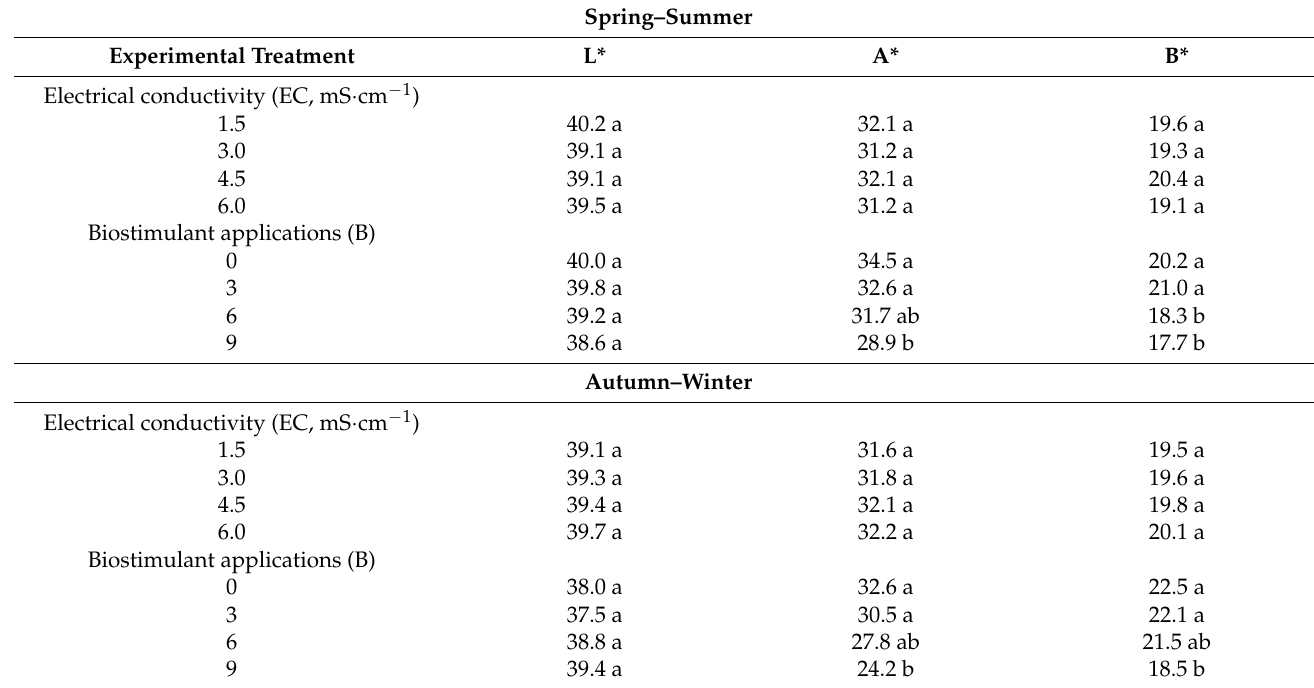
Table 3. Colour parameters of tomato fruits as affected by EC and number of biostimulant applications.